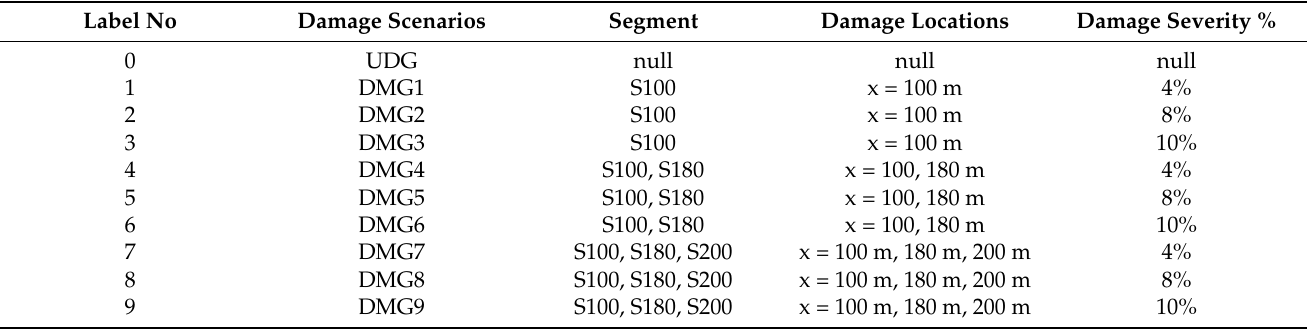
Table 5. Damage cases to carry out numerical